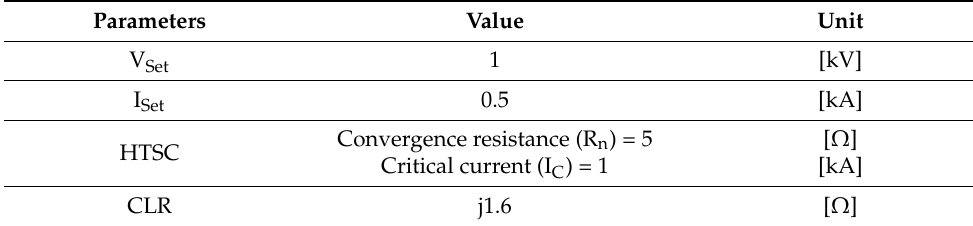
Table 2. Parameters of trigger type